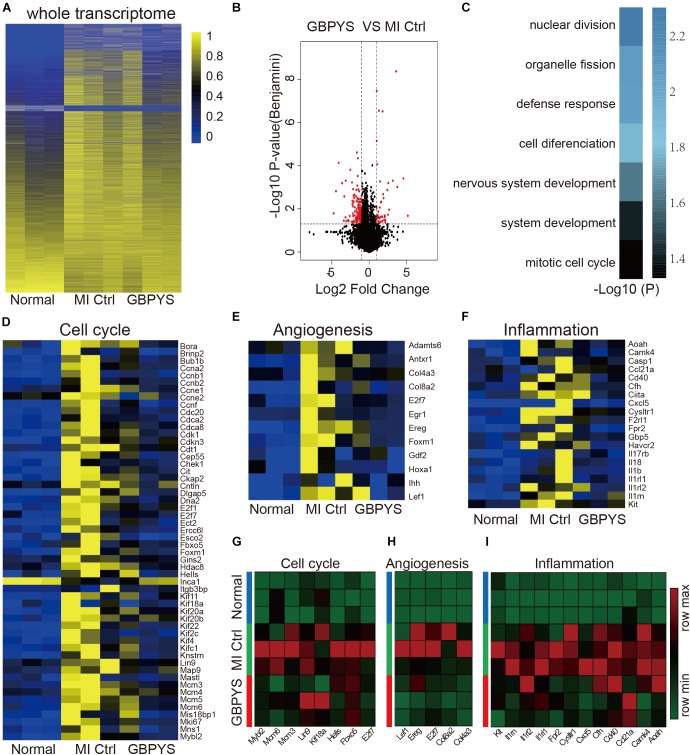
Whole-transcriptomic RNA sequencing showed that gene expression patterns of the GBPYS feeding group at 1 month after MI were more similar to those in normal mice. (A) Heat map of the whole transcriptomes showed that, compared with MI Ctrl, the gene expression patterns of GBPYS-feeding mice at 1 month after MI were more similar to those of normal mice (n = 3 per group). (B) Volcano plot of the RNA-seq data of GBPYS feeding group versus control group with regular feeding at 1 month after MI (n = 3 per group). (C) GO analyses of genes with significant change in expression level in the GBPYS feeding group versus the Ctrl group at 1 month after MI (n = 3 per group). (D) Expression of genes involved in cell cycle at 1 month. (E) Expression of vessel development genes at 1 month. (F) Expression of genes involved in inflammation at 1 month. (G–I) Expression changes of several key genes in cell cycle, angiogenesis, and inflammation pathways from the RNA-seq data at 1 month after MI were validated by qPCR. P < 0.05, Student’s t-test.